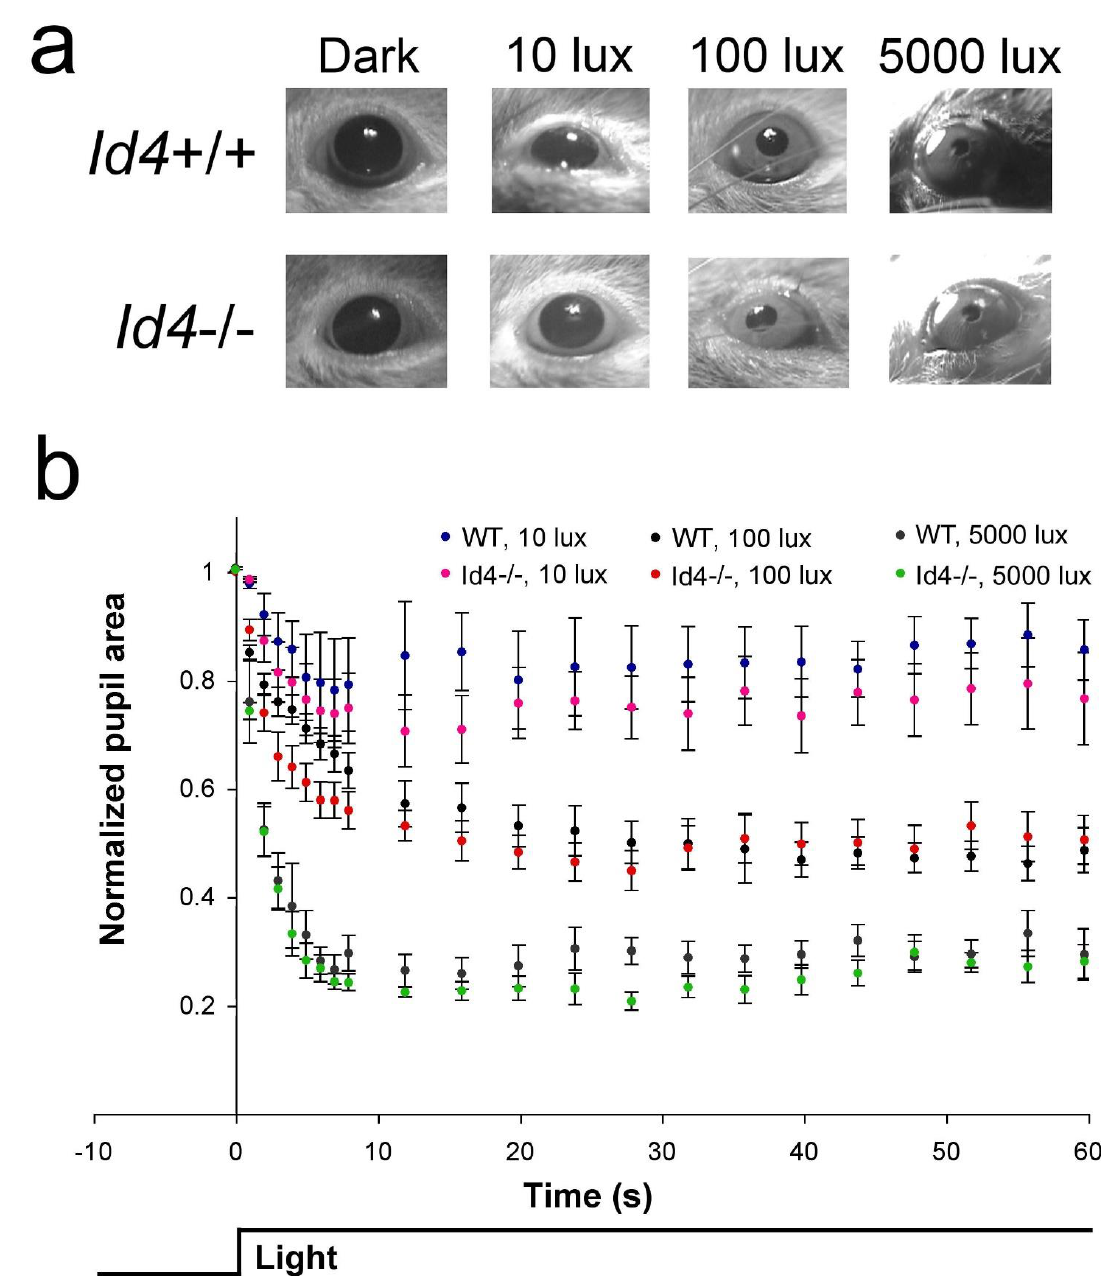
Figure 8. Pupil constriction responses are comparable between Id4 − / − and wild-type ( Id4 +/+, WT) mice. Pupil constriction response to 60 s of white light. Animals were dark adapted for at least 2 h and treated between Zeitgeber time 8 (ZT8) and ZT11. ( a ) Representative animals after 24 s of light at 10, 100, and 5000 lux light intensities. The pupil/cornea ratio was normalized to the dark-adapted aperture from time zero (normalized pupil area = 1.0). ( b ) Mean ± SEM relative pupil diameter was assessed (wild type (WT), n = 6; Id4 − / − , n = 7). Significance testing was performed by two-factor RM-ANOVA (n.s.). No differences were detected in the speed or magnitude of response at any of the three light intensities.